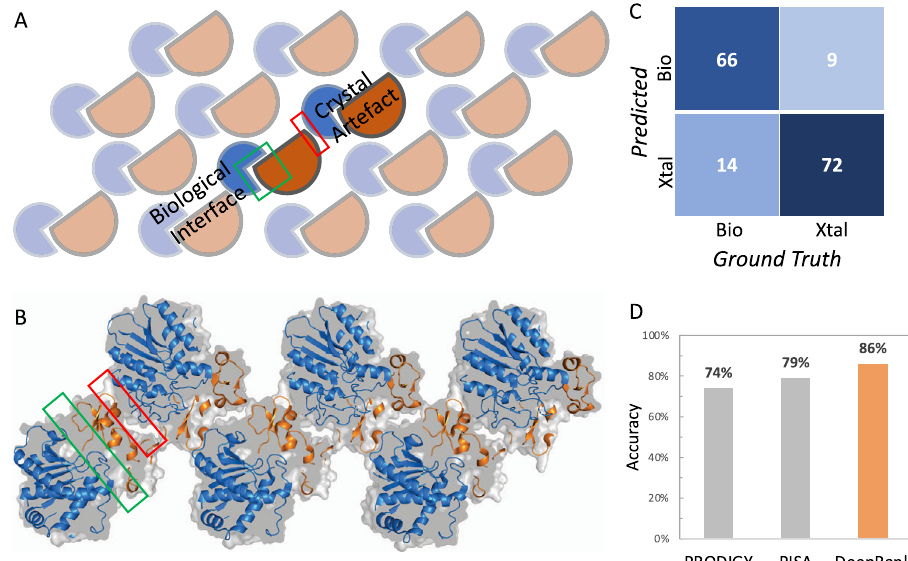
Fig. 2 Classi fi cation of biological and crystal interfaces using DeepRank. A , B . Illustration of the two types of interfaces, i.e., biological and crystal interfaces, found in a crystal. Protein molecules are orderly arranged in repetitive crystal units. Crystallographic interfaces can originate from the seeming interaction from the two neighboring crystal units, which may or may not represent biological interactions. The crystal structure shown in B corresponds to PDB entry 1ZLH. C Confusion matrix of DeepRank on the DC test dataset. D Accuracy of DeepRank, PISA, and PRODIGY-crystal on the DC